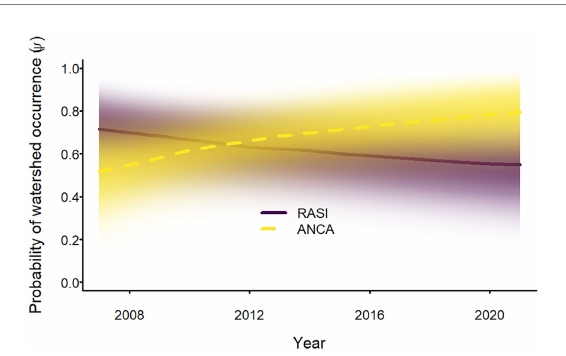
FIGURE 3 Annual probability of occurrence of adult Sierra Nevada yellow- legged frogs ( Rana sierrae ; RASI) and Yosemite toads ( Anaxyrus canorus ; ANCA) at the watershed scale in Yosemite National Park, California, United States, 2007–2021. Bold lines indicate posterior modes and the intensity of shading represents the posterior probability